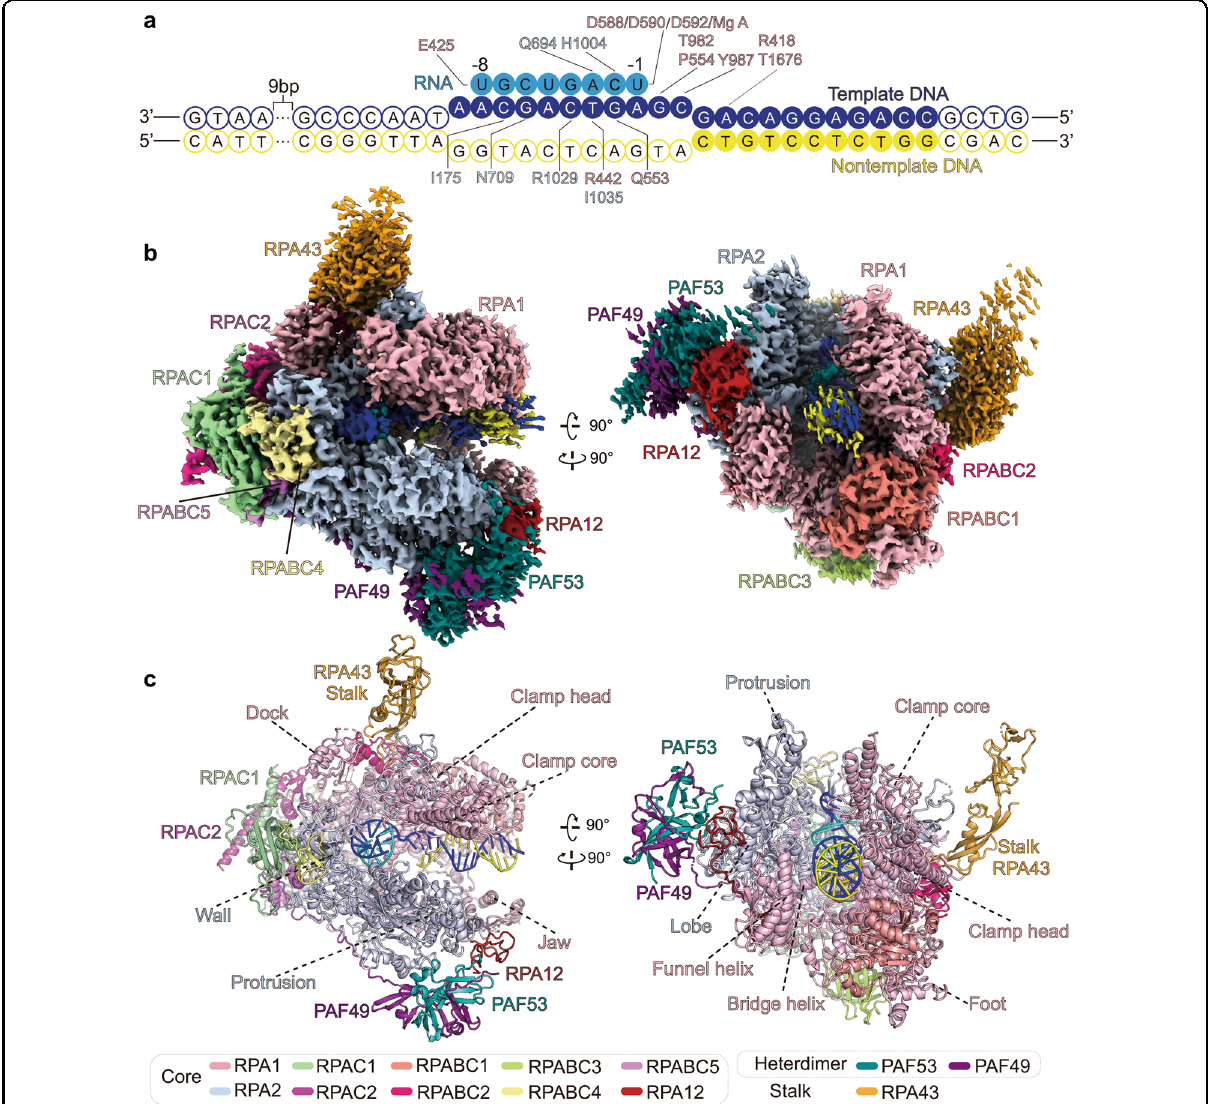
Fig. 1 Cryo-EM structure of the hPol I EC post . a Schematic model of the DNA – RNA scaffold used in EC post . RNA is numbered relative to the NTP addition site in the elongation complex. The template DNA is shown in blue, the nontemplate DNA in yellow, and RNA in cyan. The bases that built in our model are shown with color- fi lled circles. Residues involved in contacting nucleotides are indicated. b , c Cryo-EM map ( b ) and structural model ( c ) of the hPol I EC post in two different views. Color scheme is indicated and used in all the fi gures